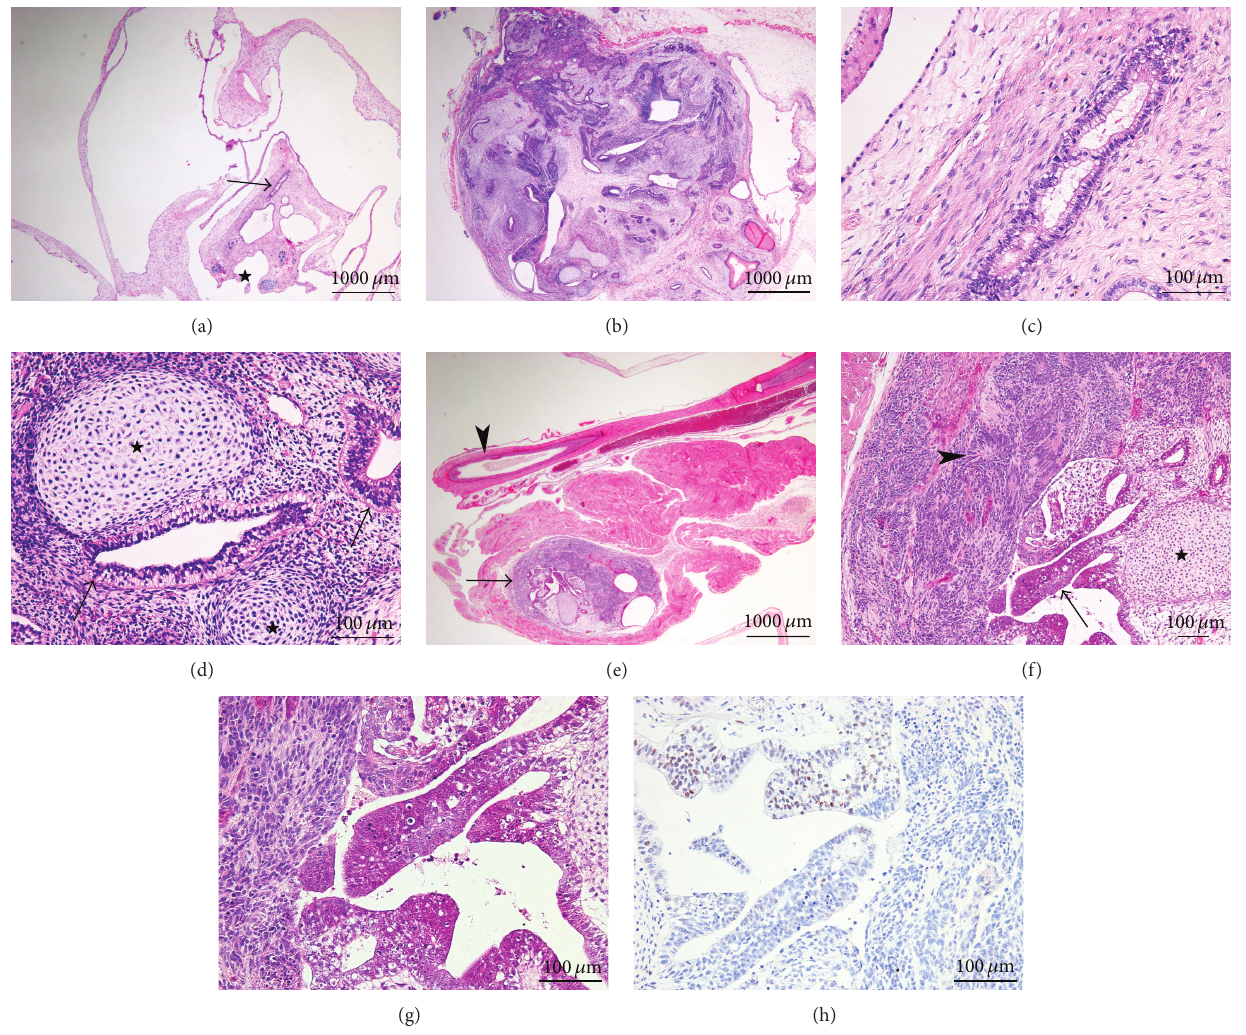
Figure 2: Human embryonic stem cells and teratoma formation. Teratomas generated were partly cystic (a) and partly solid (b) (Hematoxylin and Eosin (H&E), original magnification 20x). Tumors were composed of structures derived from all three germ layers; cystic glands were divided by paucicellular mesenchymal septa, in which a few slightly immature glandular structures were embedded (c, H&E 200x). Glands ( arrows ) and immature cartilage plates ( stars ) are shown as derivatives from the endodermal and mesodermal layers, respectively (d, H&E 200x). In one tumor, a small and solid 0.2 cm nodule ( arrow ) was located in an intramuscular position at a distance of 0.2 cm from the main cystic portion and close to the mouse vas deferens ( arrowhead ) (e, H&E 20x). The nodule was composed of immature neuroglial tissue ( arrowhead ), cartilage ( star ), and glands; a minority of the glandular structures were atypical ( arrow ) (f, H&E 100x). At higher magnification (g,H&E200x),theseglandswereformedofcellsshowingnuclearatypiaandincreasedapoptoticrate.Uponimmunohistochemicalevaluation, MYC reactivity was faint and focal, expressed in approximately 20% of the atypical cells (h,